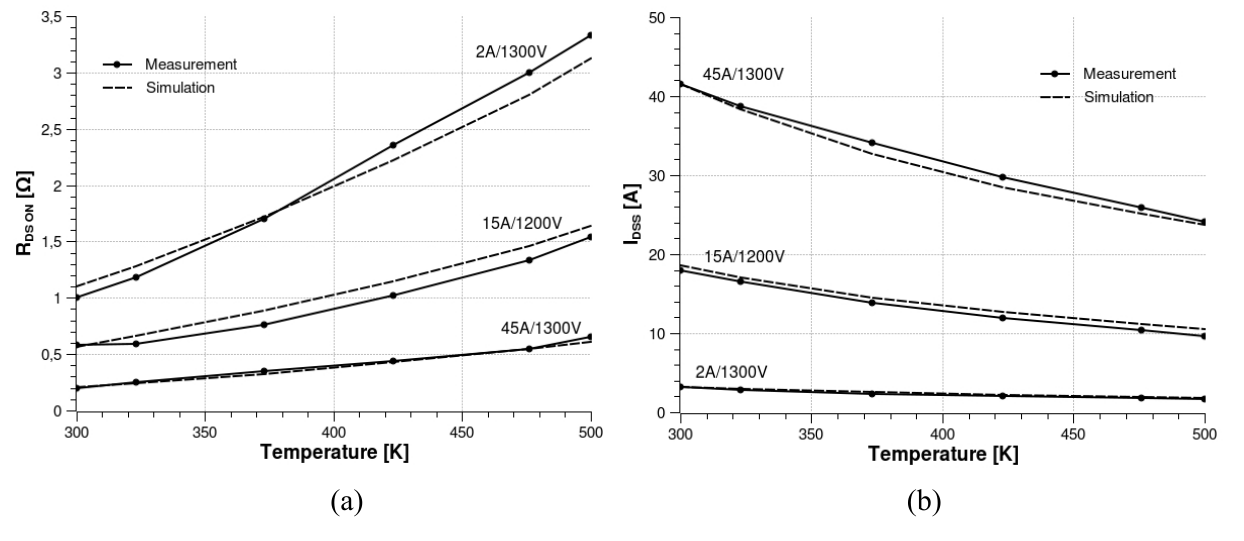
Figure 11. Comparison between experimental data and simulation results at various temperatures of three SiC-JFETs samples. (a) On-resistance and (b) saturation